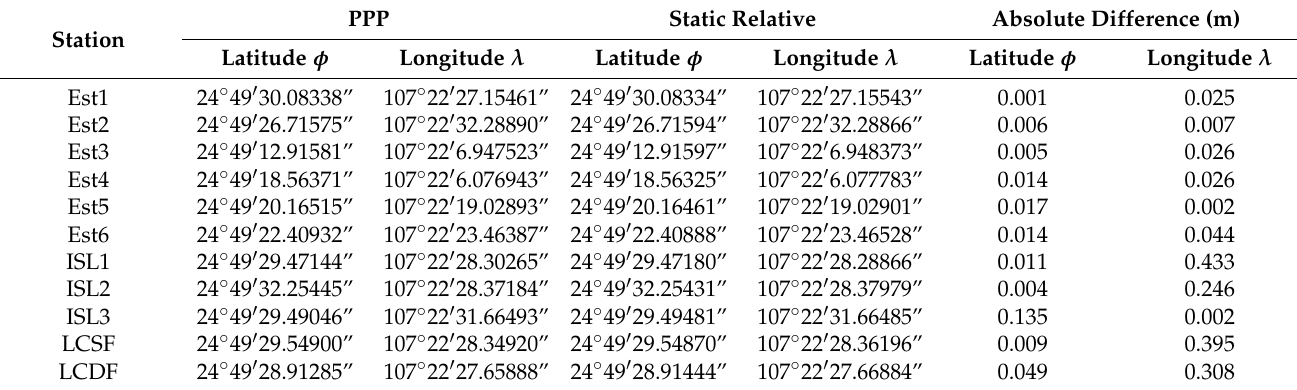
Figure 13. Absolute coordinates differences between the static relative and the PPP methods. Table 9. Absolute difference between the PPP and the static relative methods in m. Station